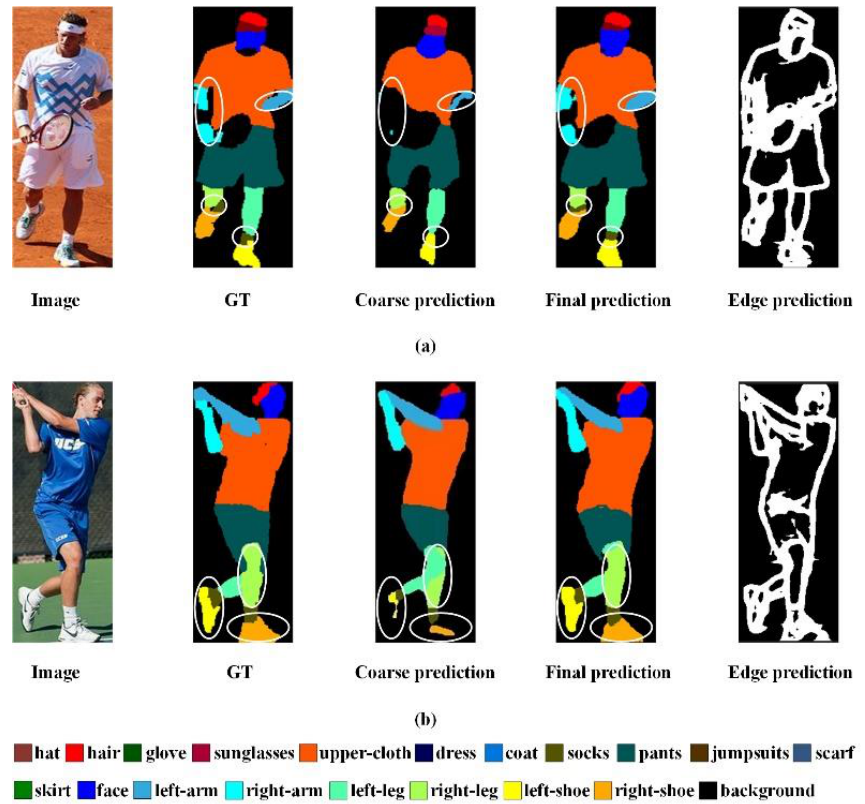
Figure 6. The effect of edge detection module. ( a ) The effect of the edge detection module on small targets like sock; ( b ) The effect of the edge detection module on the categories of left and right symmetrical parts of the human body, avoiding the confusion of categories such as left and right legs and shoes.